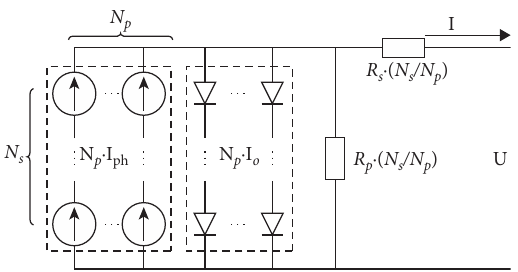
Figure 2: The equivalent circuit model of PIN array.